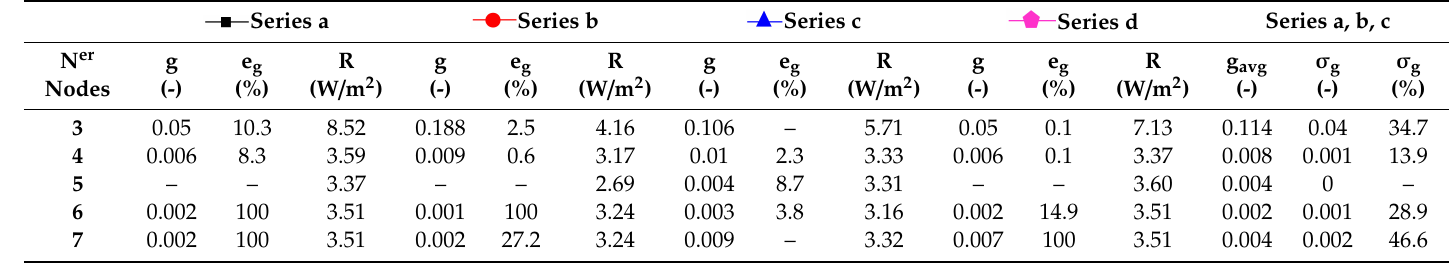
Table 5. Ceiling. g value. Summary of the results using models that include solar radiation. Output: ϕ . Where e g is the error and R is the average of the residuals given by LORD for each data